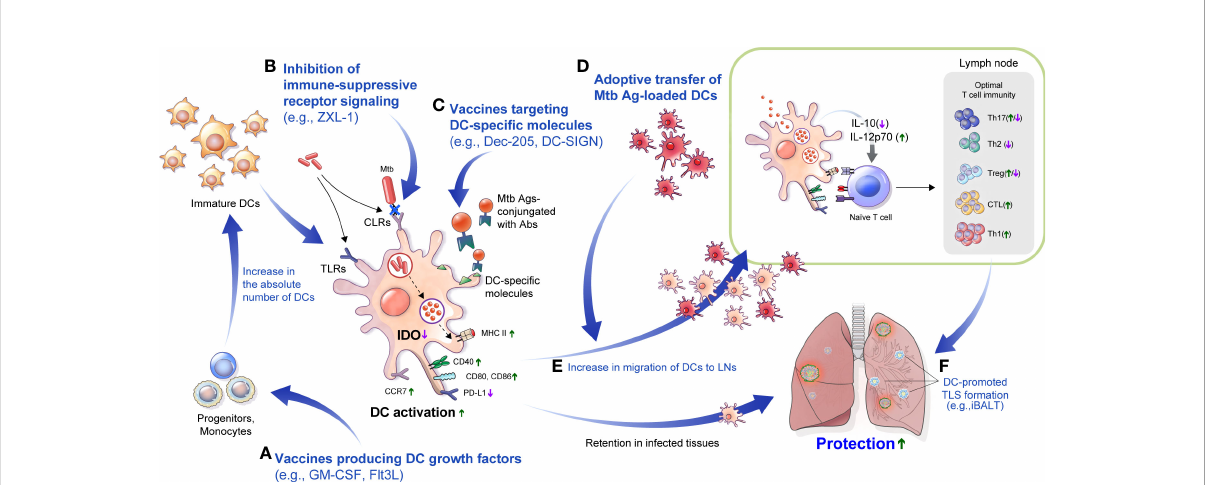
FIGURE 3 DC-based approaches to overcome TB disease. (A) Injection of Flt3L, GM-CSF or immunization with a vaccine that produces Flt3L, GM-CSF could increase the absolute number of DCs. (B) In Mtb infection, various CLRs that modulate the function of DCs could be blocked to promote DC maturation. For example, an aptamer such as ZXL-1 can inhibit the binding of ManLAM and mannose receptor. (C) Molecules such as DC- SIGN and Dec-205, mainly expressed on DCs, can be major targets of DC-targeted vaccines, which can be used to enable effective Ag delivery. (D) Adoptive transfer of DCs maturated with an Mtb-Ags increases the absolute number of DCs for interaction with T cells and can be used as a prime or booster vaccination, or as adjunctive therapy for antibiotic therapy to increase treatment ef fi ciency. (E) Ef fi ciently maturated DCs can interact with T cells through improved migration, which can help to con fi gure optimal T cell immunity. (F) Ef fi cient immunization with DCs can induce tertiary lymphoid structures formation such as iBALT, and can provide effective protection against subsequent infection. LNs, lymph nodes; Flt3L, FMS-like tyrosine kinase 3 ligand; GM-CSF, granulocyte-macrophage colony-stimulating factor; CLRs, C-type lectin receptors; DC-SIGN, DC-speci fi c intercellular adhesion molecule-3 grabbing nonintegrin; TLS, tertiary lymphoid structure; iBALT, inducible bronchus – associated lymphoid